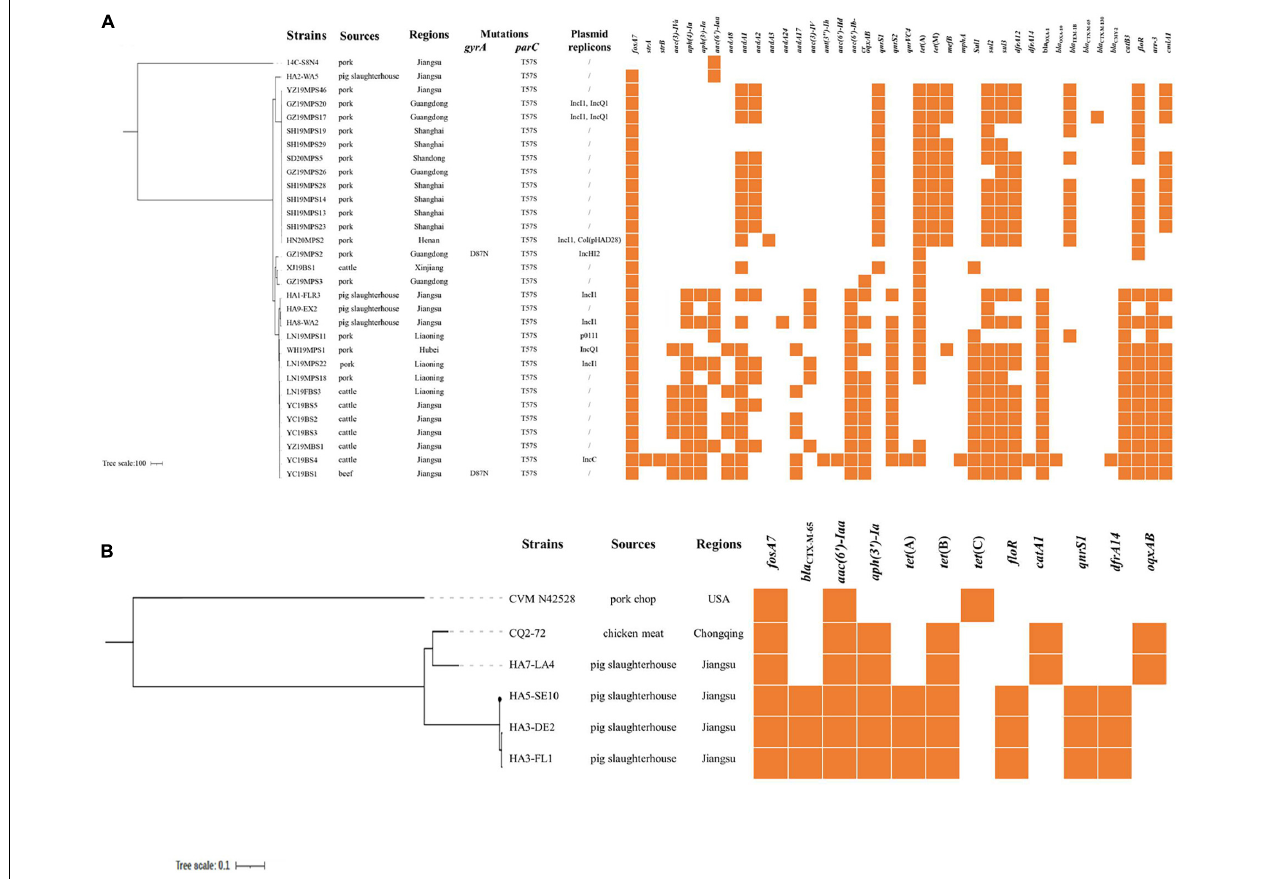
FIGURE 1 | (A) Phylogenetic tree of fosA7 -positive ST40 S. Derby compared with fosA7 -negative ST71 S . Derby. Antibiotic resistance genes, mutations, and plasmid replicons are shown. (B) Phylogenetic tree of fosA7 -positive S . Reading compared with S . Reading isolate CVM N42528 (GCA_001481335.1). Antibiotic resistance genes are shown. No mutations or plasmid replicons are identified.